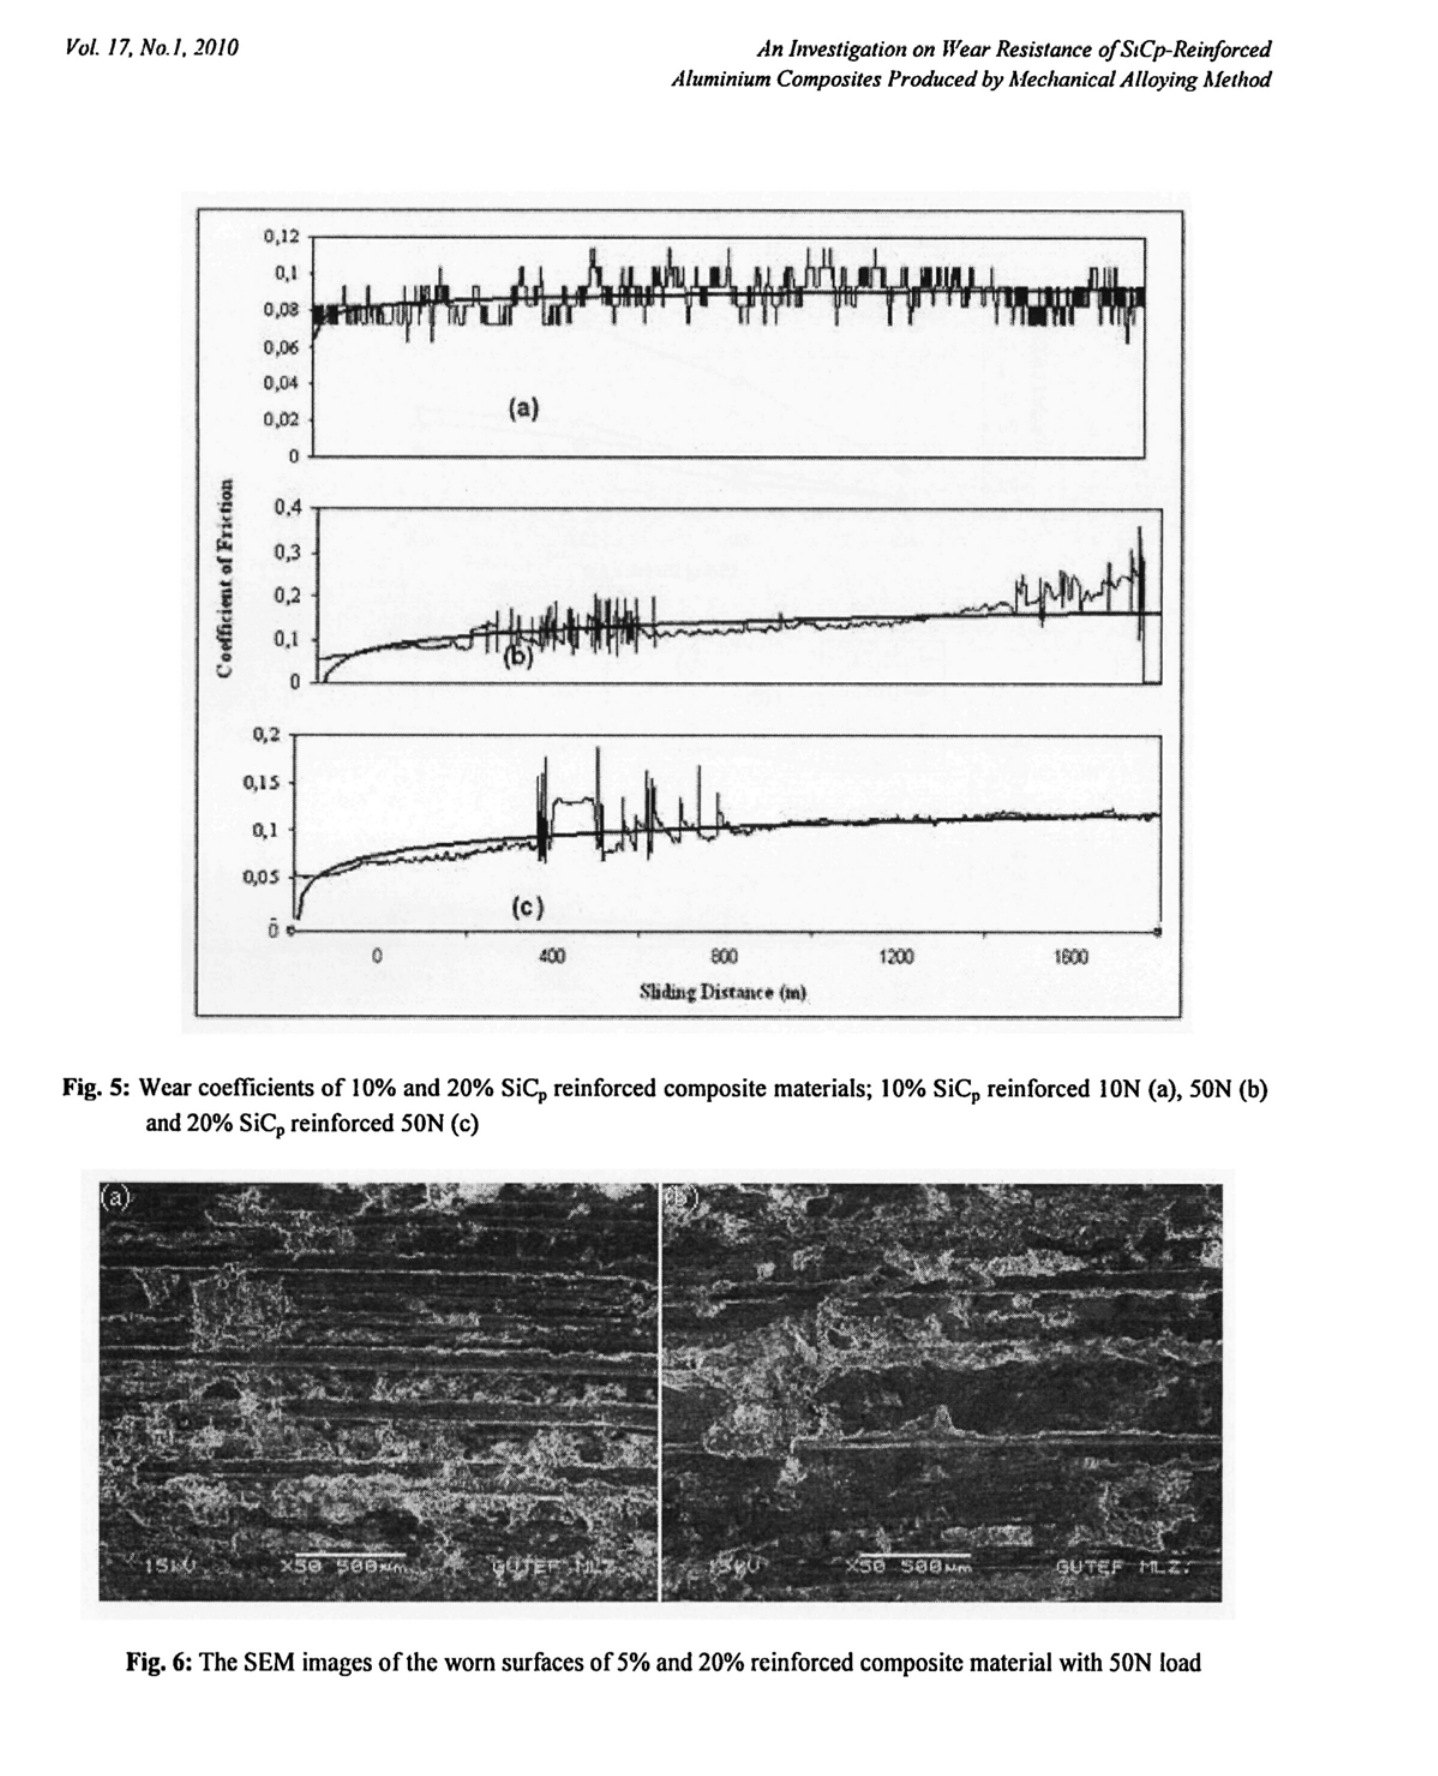
Fig. 6: The SEM images of the worn surfaces of 5% and 20% reinforced composite material with SON load